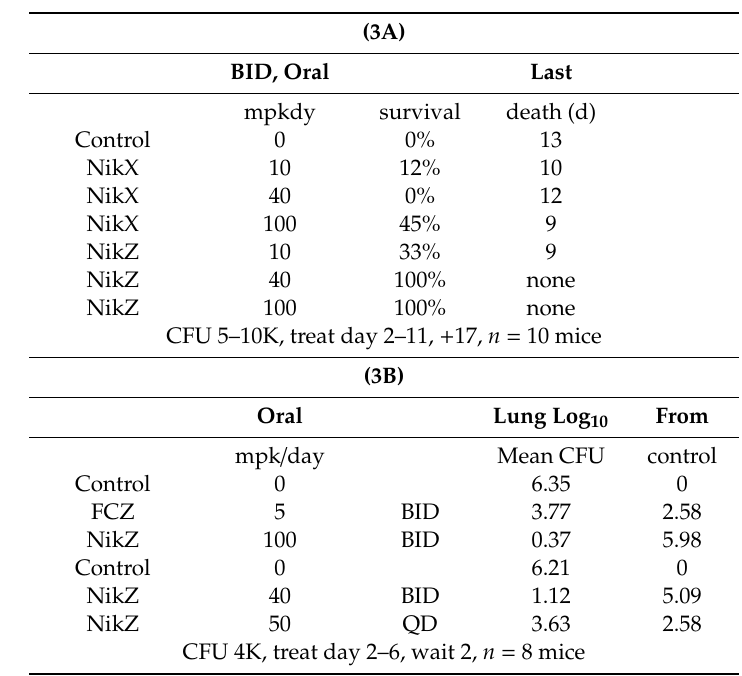
Table 3. Pulmonary coccidioidomycosis ( 3A ) survival, ( 3B ) organ burden